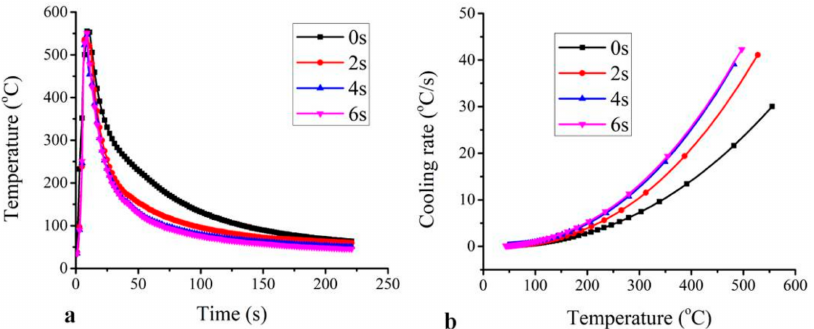
Figure 12. ( a ) The heating and cooling history of welded joints with and without USV; and ( b ) the cooling rate vs. temperature of welded